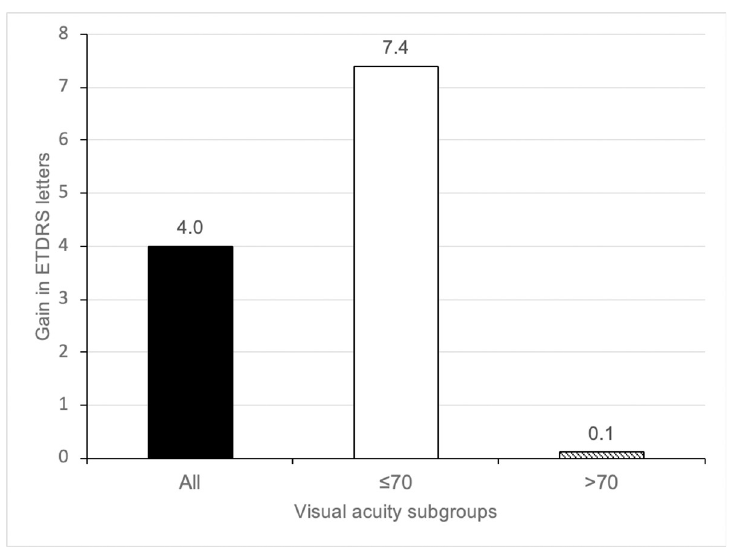
Fig 2. A. Proportion of eyes with � 10 letters gained at 12 months in the NWL cohort and the VIVID and VISTA trials. B. Proportion of eyes with � 15 letters gained at 12 months in the NWL cohort and the VIVID and VISTA trials.